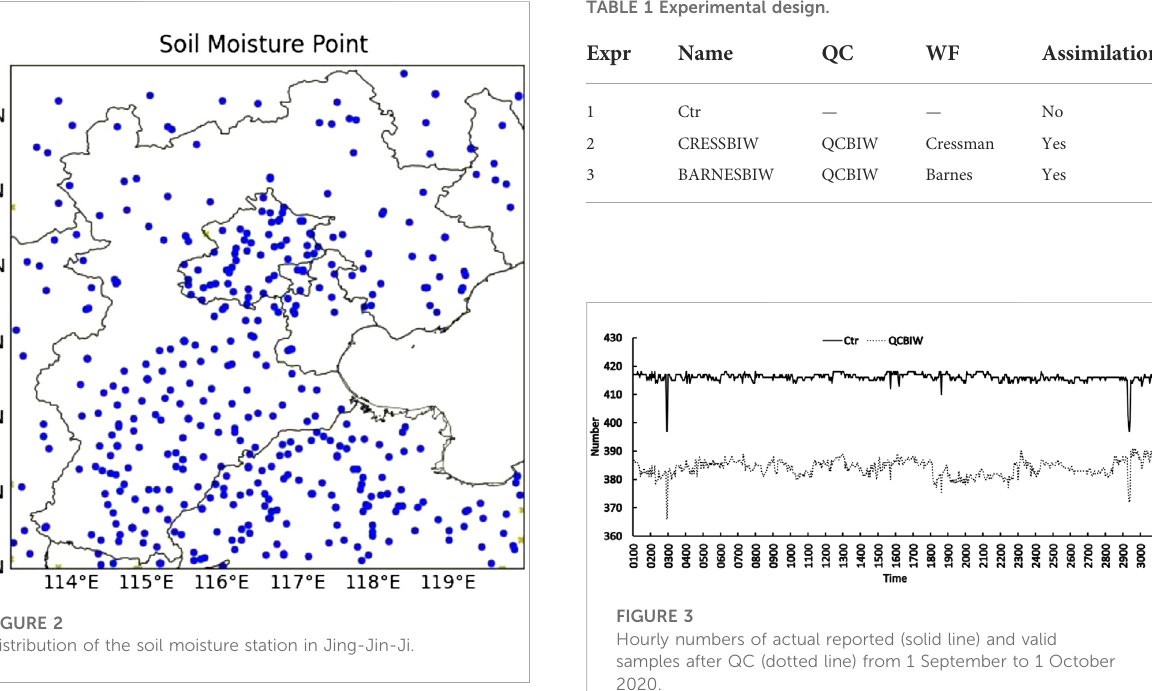
FIGURE 3 Hourly numbers of actual reported (solid line) and valid samples after QC (dotted line) from 1 September to 1 October